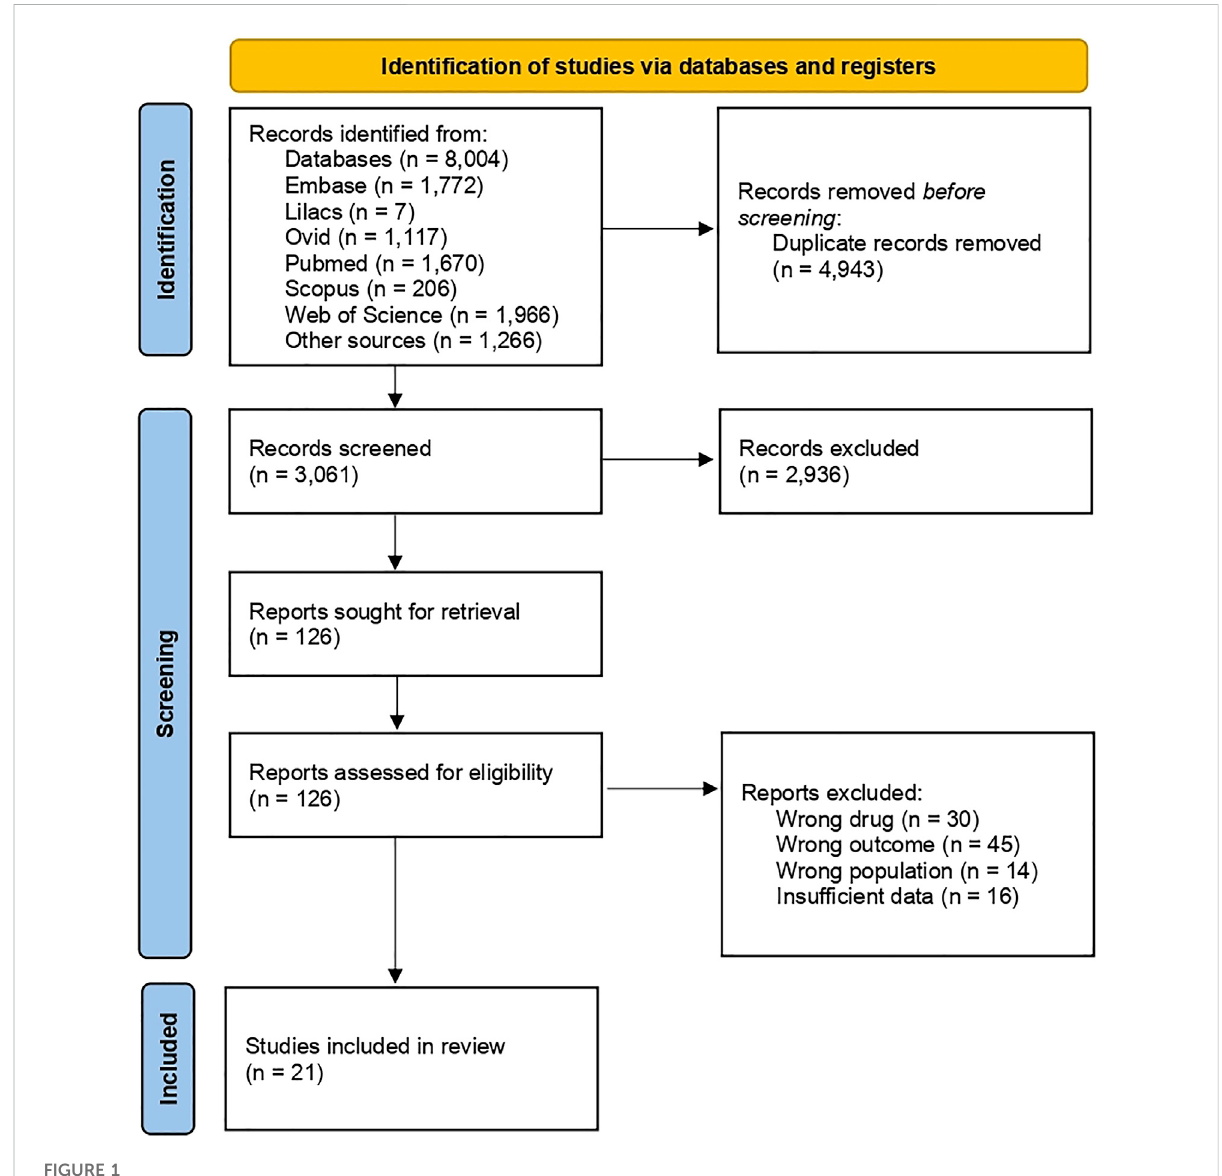
FIGURE 1 Flow chart of search